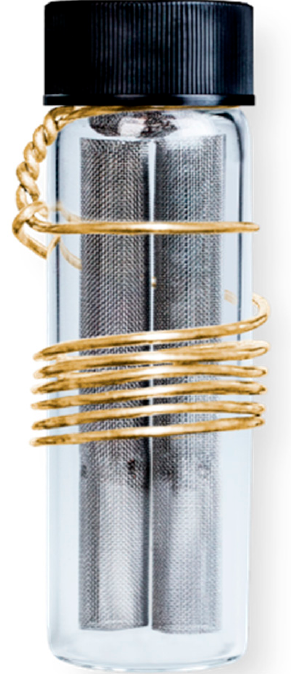
Figure 2. Beacon Passive Soil Gas Sampler.